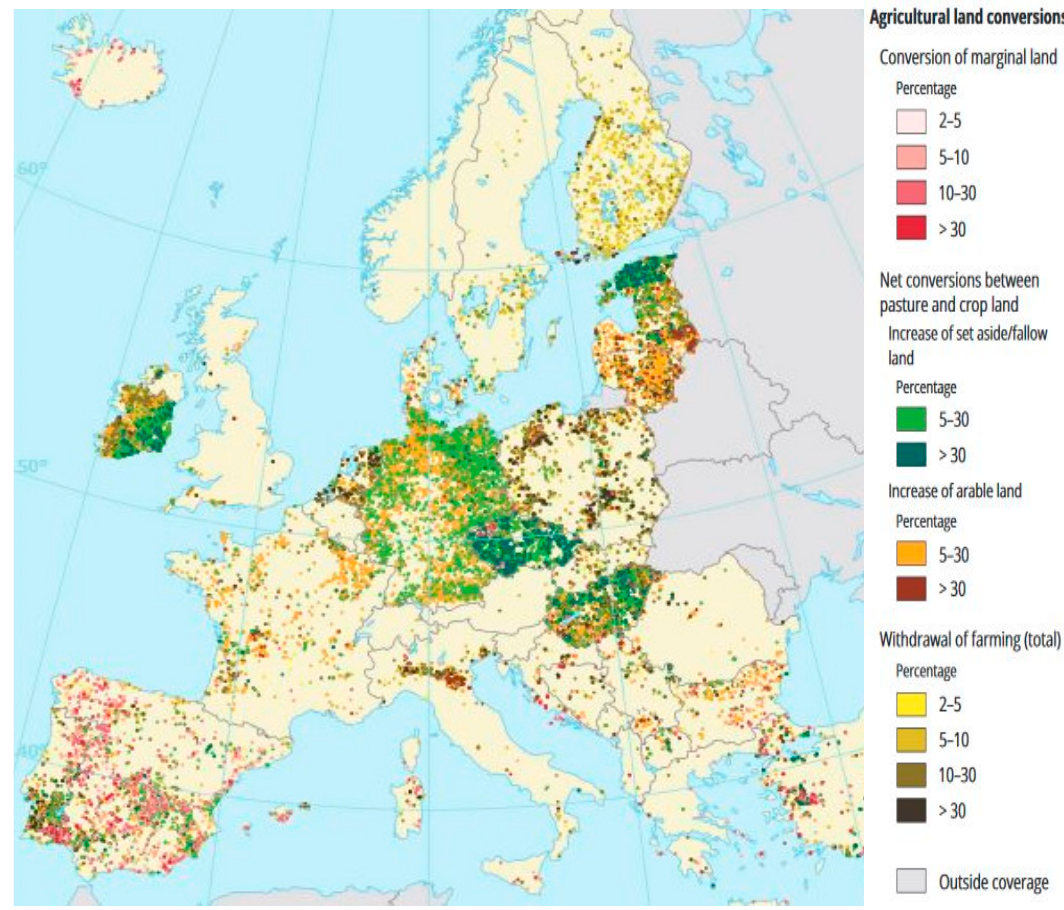
Figure 3. Agricultural conversions, 2006–2012 [10].